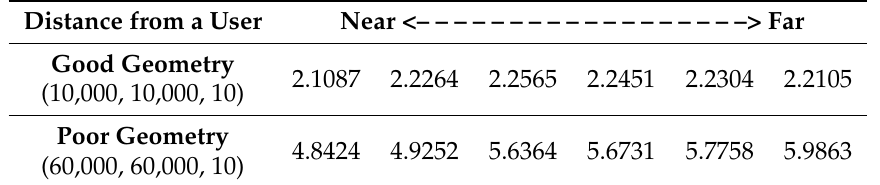
Table 2. PDOP in accordance with the position of the reference